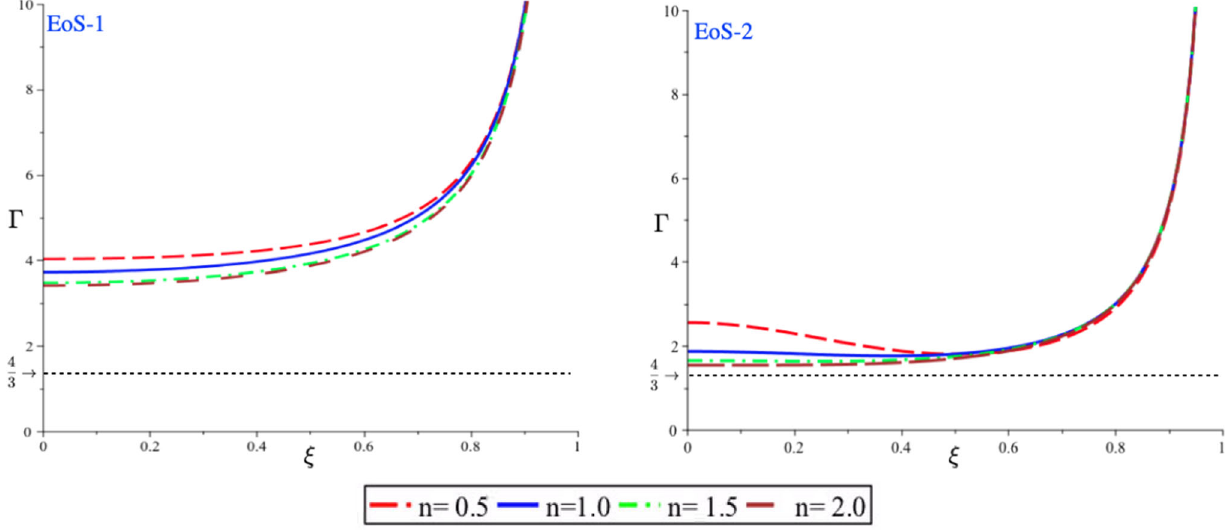
Fig. 4 The adiabatic index (cid:10) as a function of the dimensionless radius ξ = r / r b for the EoS-1 (left) and EoS-2 (right), for different values of the index n and σ = 0 . 12. The C5 condition is completely satisfied by both models Ref. [16], exhibiting a maximum for g rr at some point, ξ , within the